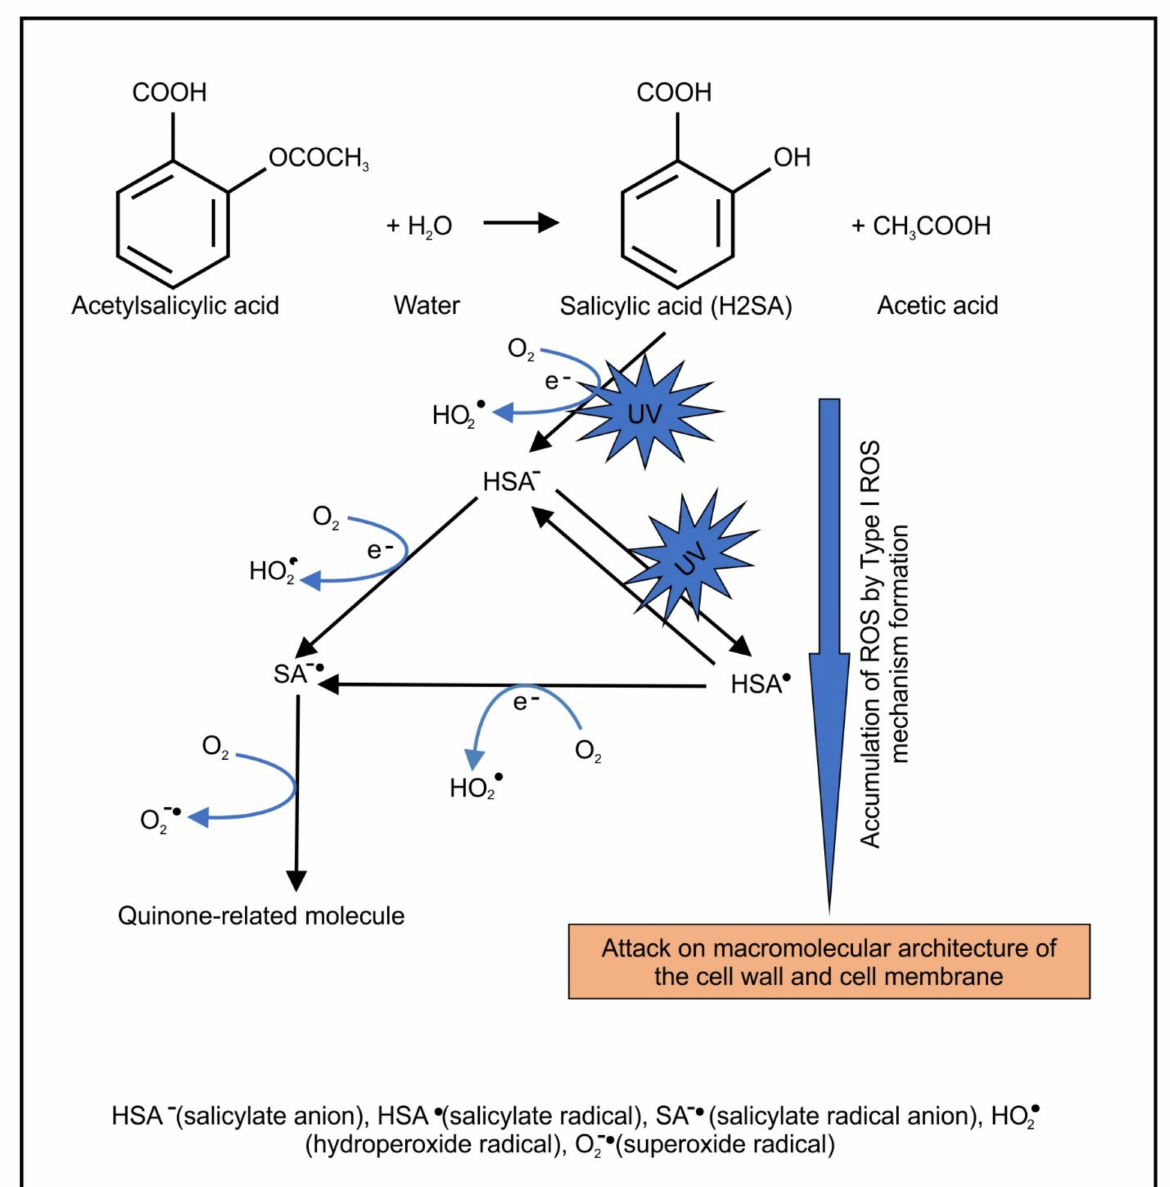
Figure 1. Proposed mechanism of UV-induced photosensitizer and accumulation of ROS via Type I